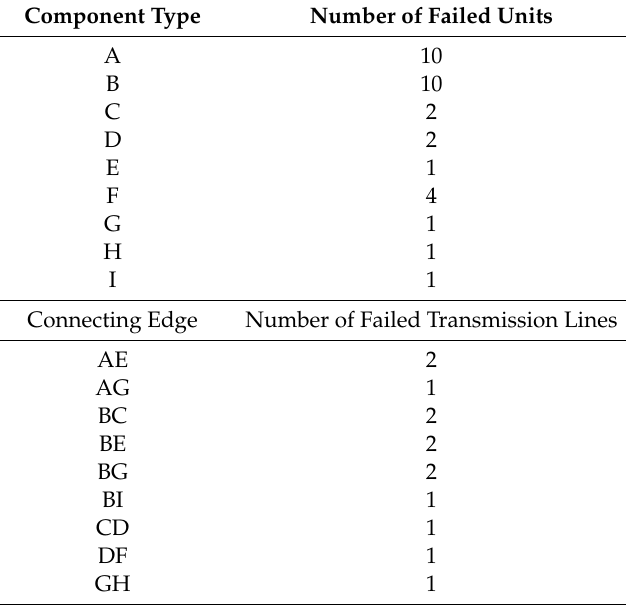
Table 2. Failure of Substation Units under Terrorist Attack.